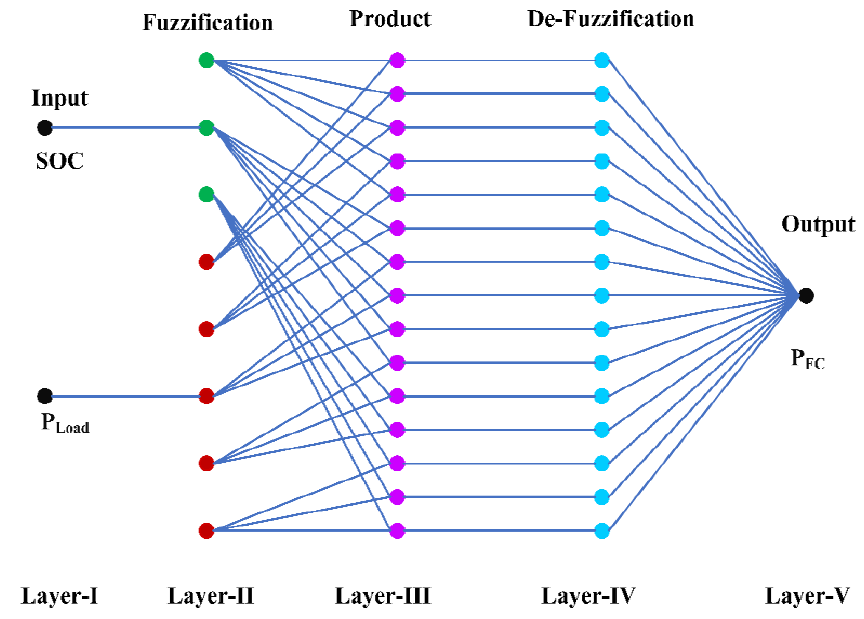
Figure 8. Structure of ANFIS.